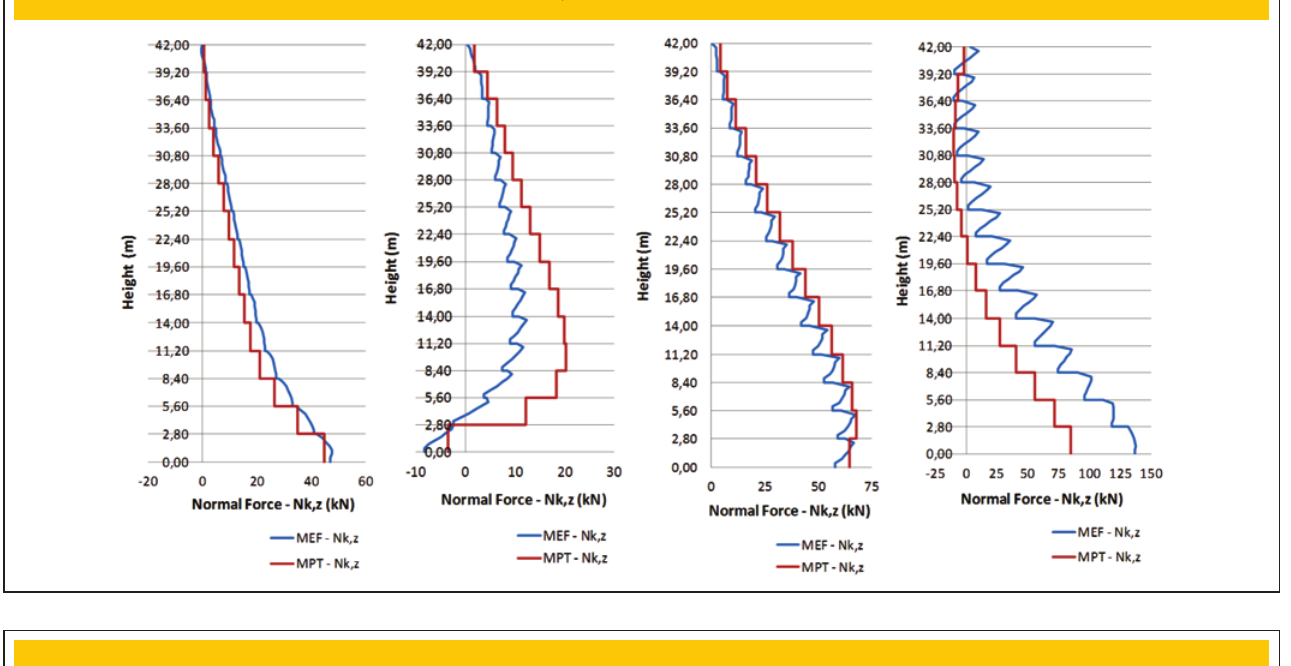
Table 4 – Comparison of the maximum normal forces on the walls